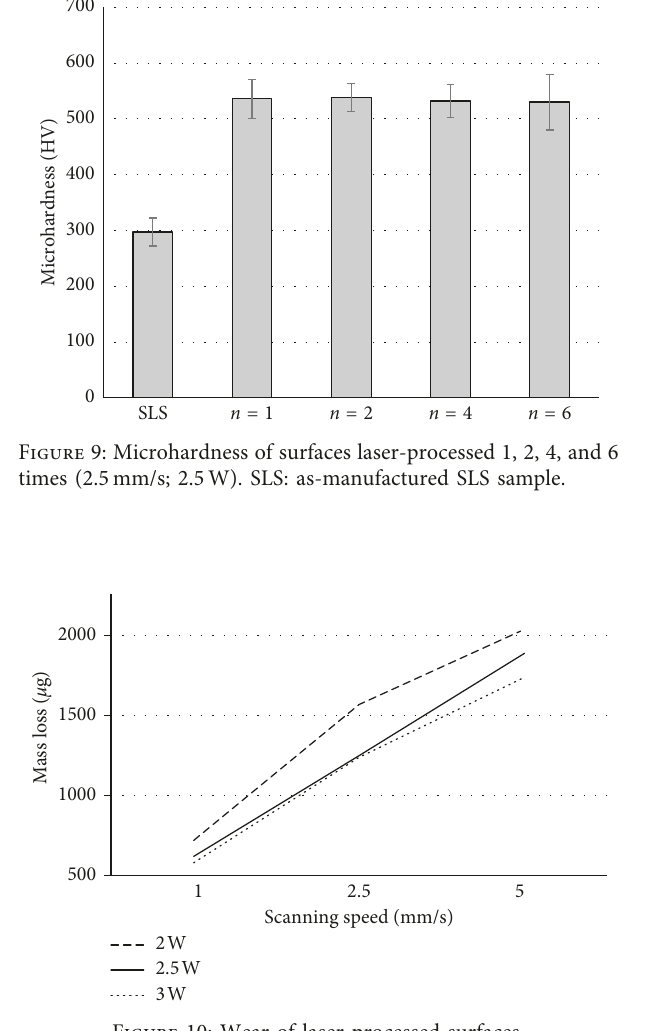
Figure 10: Wear of laser-processed